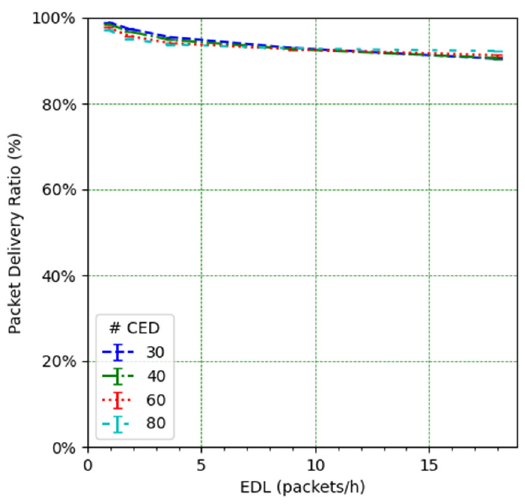
Figure 12. PDR for EDs in unconfirmed transmission mode vs. EDL.